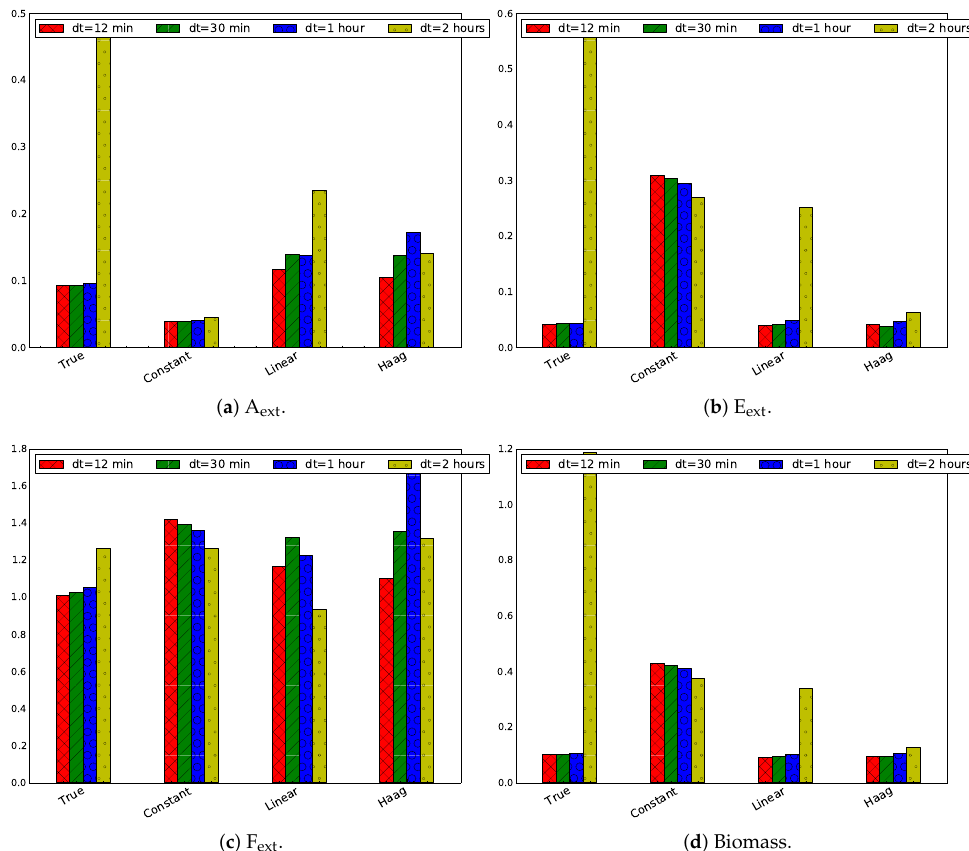
Figure 12. Absolute values of the absolute tracking error divided by the number of measurements for the four states for different sampling times with H = H e = H p = 4